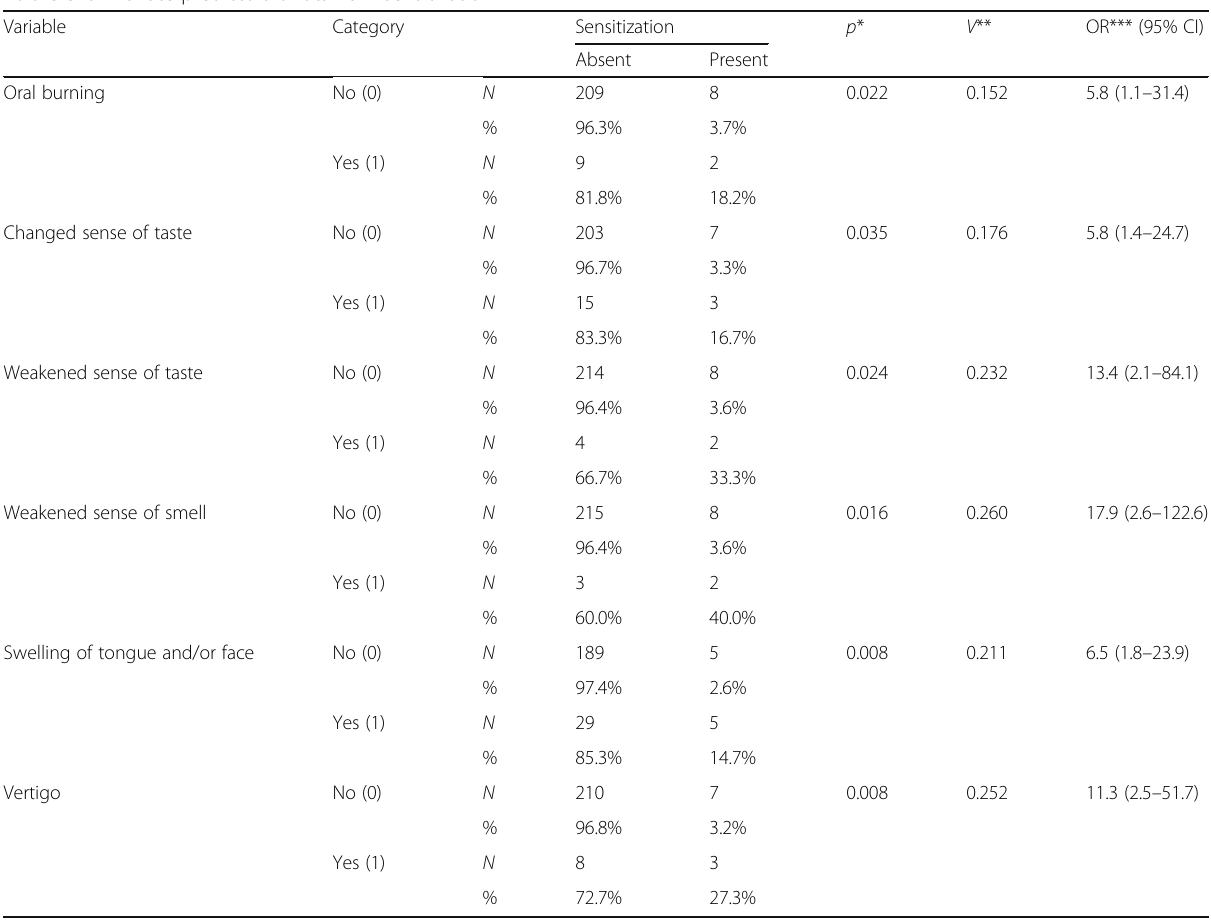
Table 3 Univariate predictors of titanium sensitization